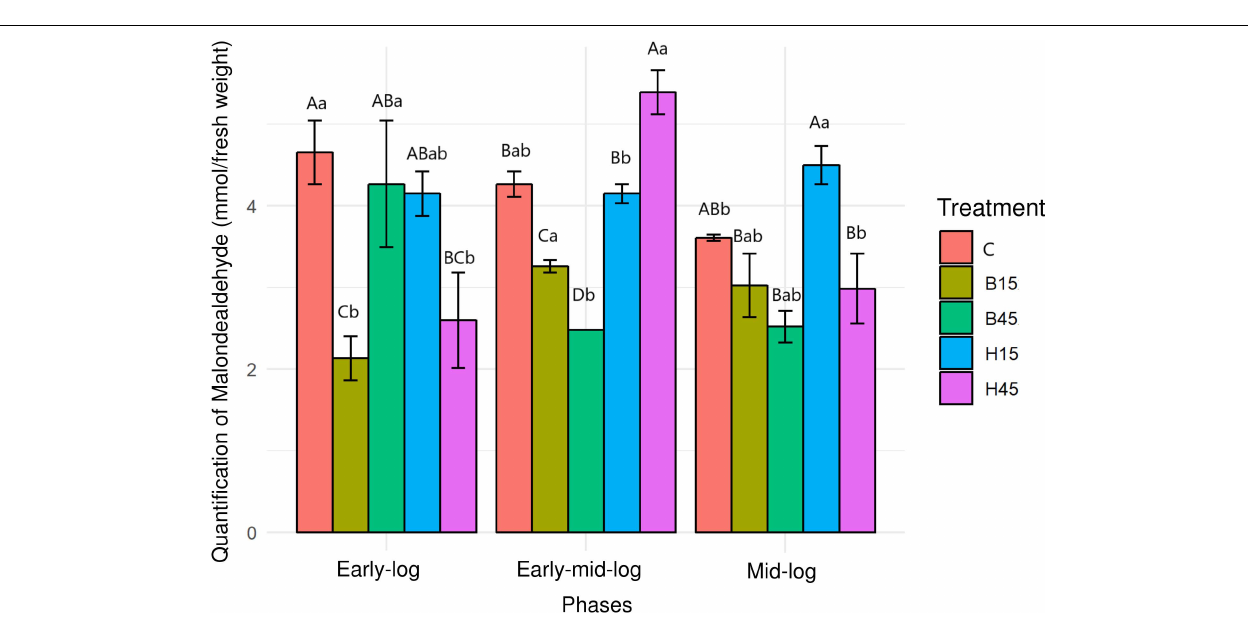
FIGURE 5 | Quantification of MDA from Pseudomonas sp. CMA 6.9 in control treatments (C) and with the herbicides Boral R (cid:13) (B15 and B45) and Heat R (cid:13) (H15 and H45) in the three growth phases indicated. Data were obtained in triplicate for each treatment and statistically analyzed using a randomized complete block design using the Duncan test ( p < 0.05). Error bars represent standard errors of the means. Different uppercase letters represent statistically significant differences between treatments at the same time; lower-case letters represent statistically significant differences between treatments at different times.